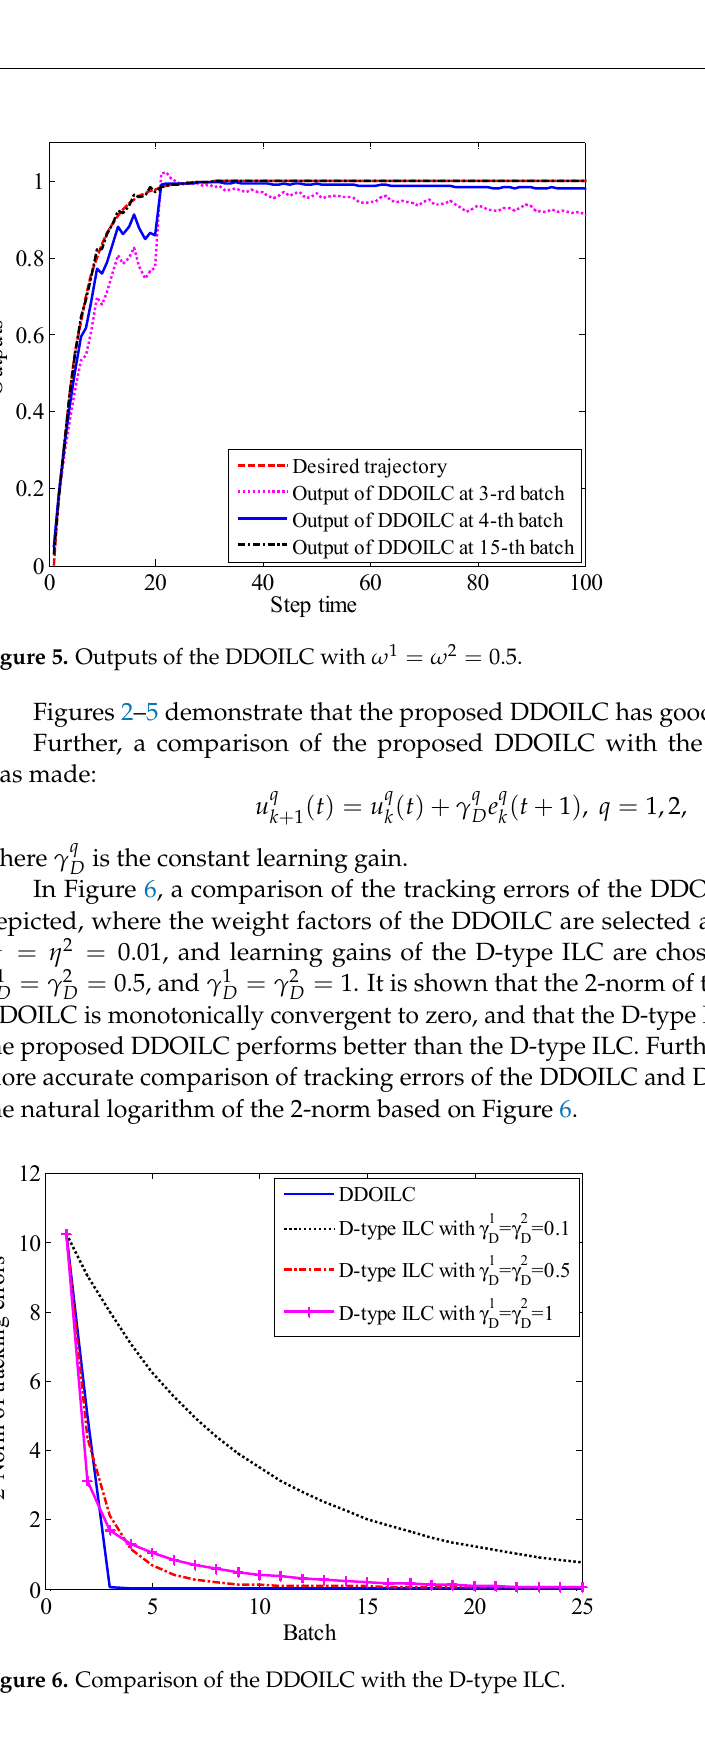
Figure 6. Comparison of the DDOILC with the D-type ILC.